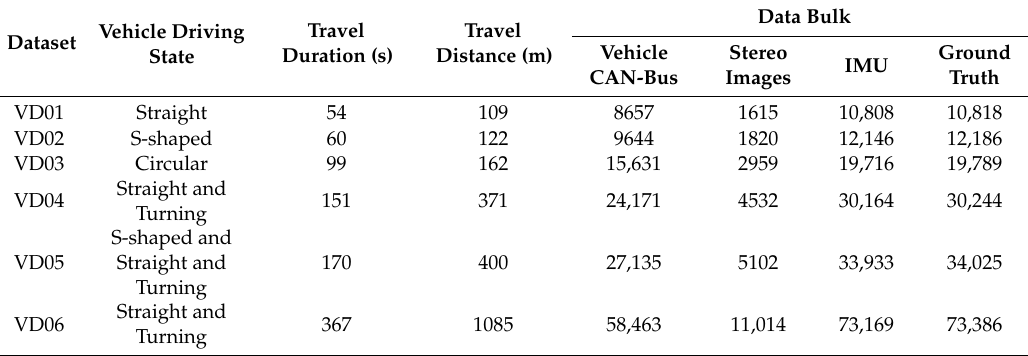
Table 3. List of the real-world experimental datasets adapted from